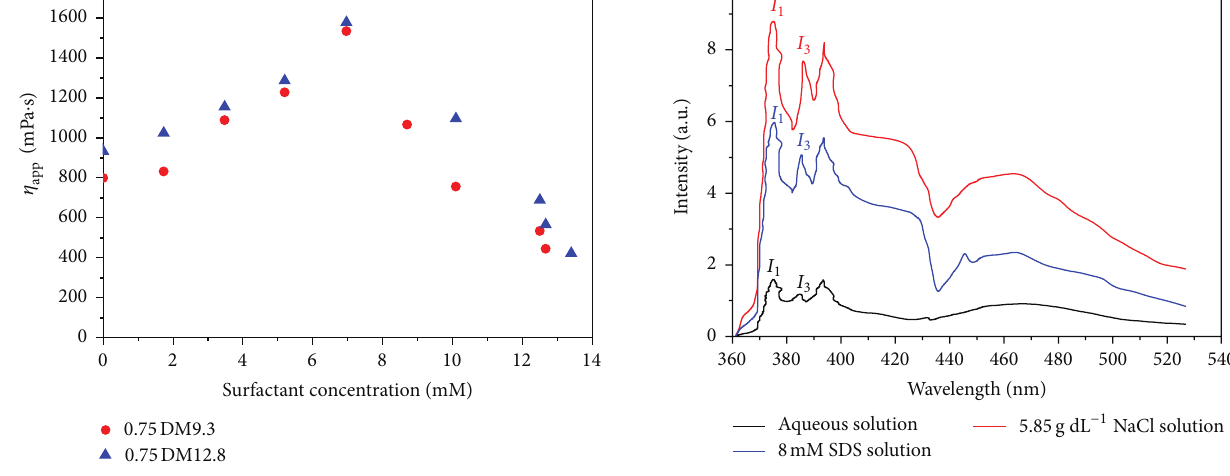
Figure 12: Variation of apparent viscosity of as a function of SDS concentration for copolymers 0.75DM12.8 and 0.75DM9.3 at 0.5 g dL −1 (shear rate 7.34 s −1 , 𝑇 = 25 ∘ C).